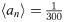
Larger mixtures activate fewer channels.(A) Comparison of the excitations en for odors with few ligands (mixture size s = 8, upper panels) and many ligands (s = 64, lower panels) at α = 1.3. en for a single odor (left panels) and histograms for all odors (right panels) are shown. Larger mixtures exhibit fewer active channels (dark blue), for which the excitations are above threshold (red line). (B) Numerically determined 〈an〉 as a function of s for various inhibition strengths α at small (σ/μ = 1, solid lines) and large concentration variability (σ/μ = 10, dashed lines) at NL = 104. (C) Numerically determined 〈an〉 as a function of σ/μ for various α. (A–C) Additional model parameters are NR = 32, NL = 256, pi = 0.1, μi = σi = 1, and λ = 1. The gray dotted line in B and C indicates a single expected active channel in humans, 〈an〉=1300.